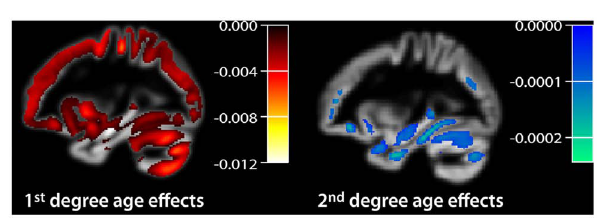
FIGURE 2 |Application of a polynomial age model in a large cross-sectional healthy subjects sample of voxel-based morphometry data ( n = 1094, 18–94years, normalized gray matter volume segment). Here we depict the estimates of first and second degree beta coefficients. We applied a voxel threshold of t = 5.097, p < 0.05, FWE